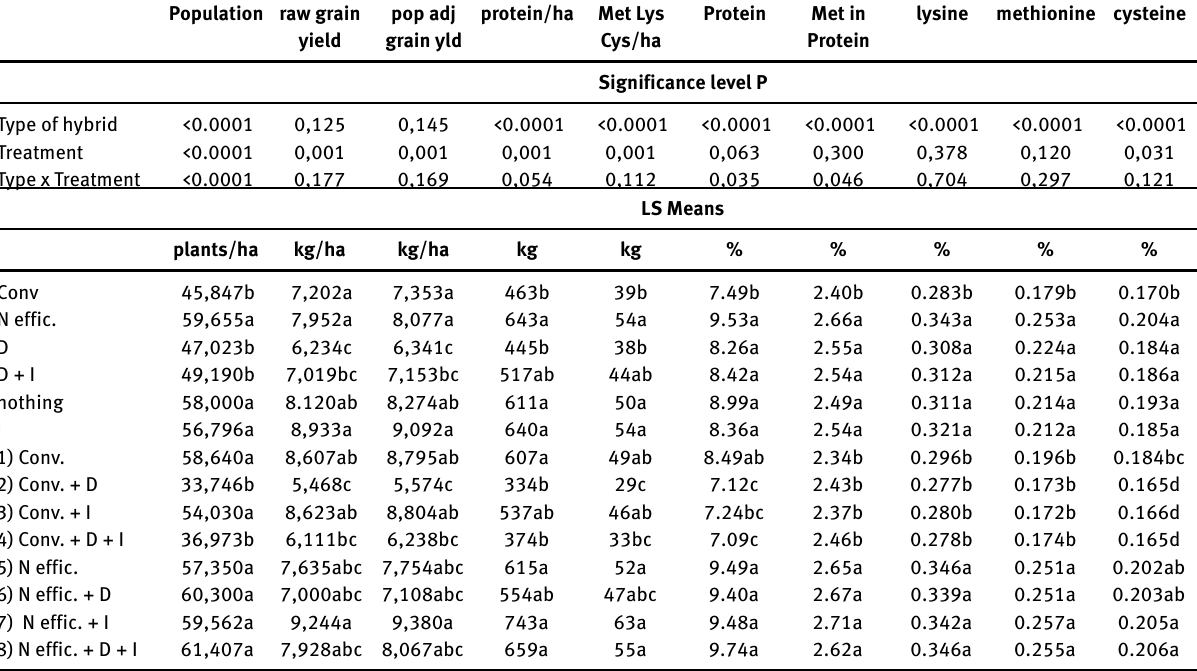
Table 4. Effects of types of hybrids and seed treatments on agronomic and grain